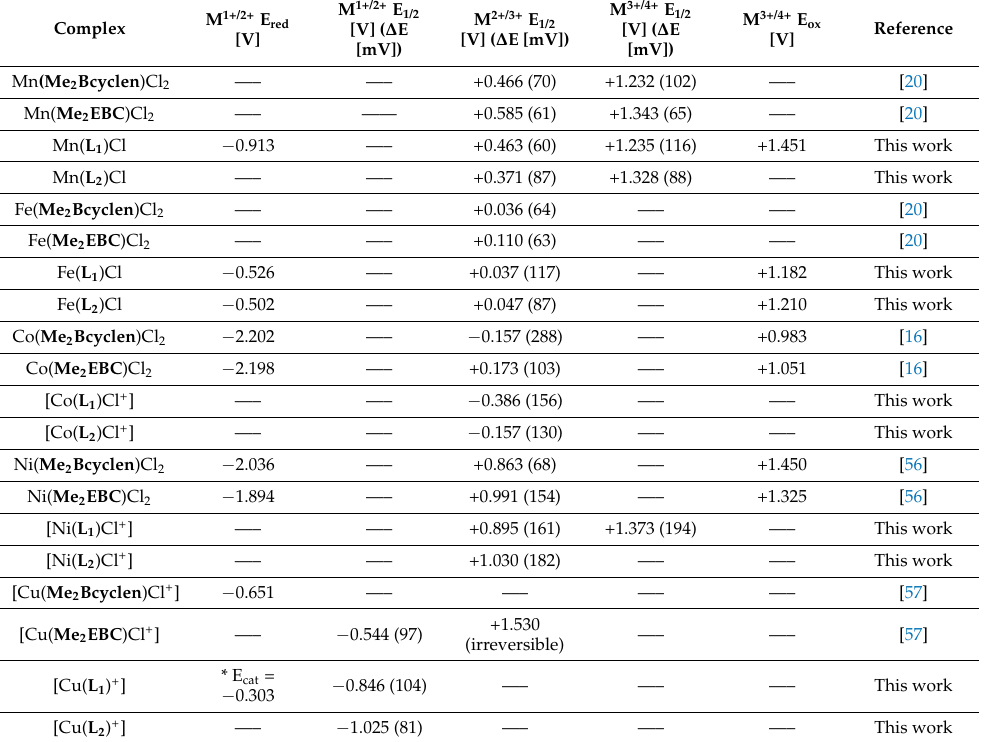
Table 2. Redox potentials vs. SHE for M L 1 and M L 2 complexes (0.001 M in acetonitrile). Reference compounds of the same metals with Me 2 Bcyclen and Me 2 EBC ligands (see Figure 1) are included for comparison.